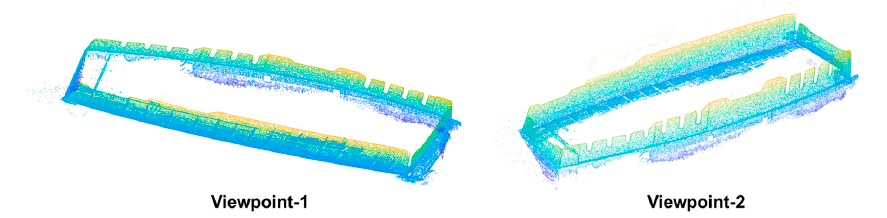
Figure 7. Measurement experiments during wing-body assembly.